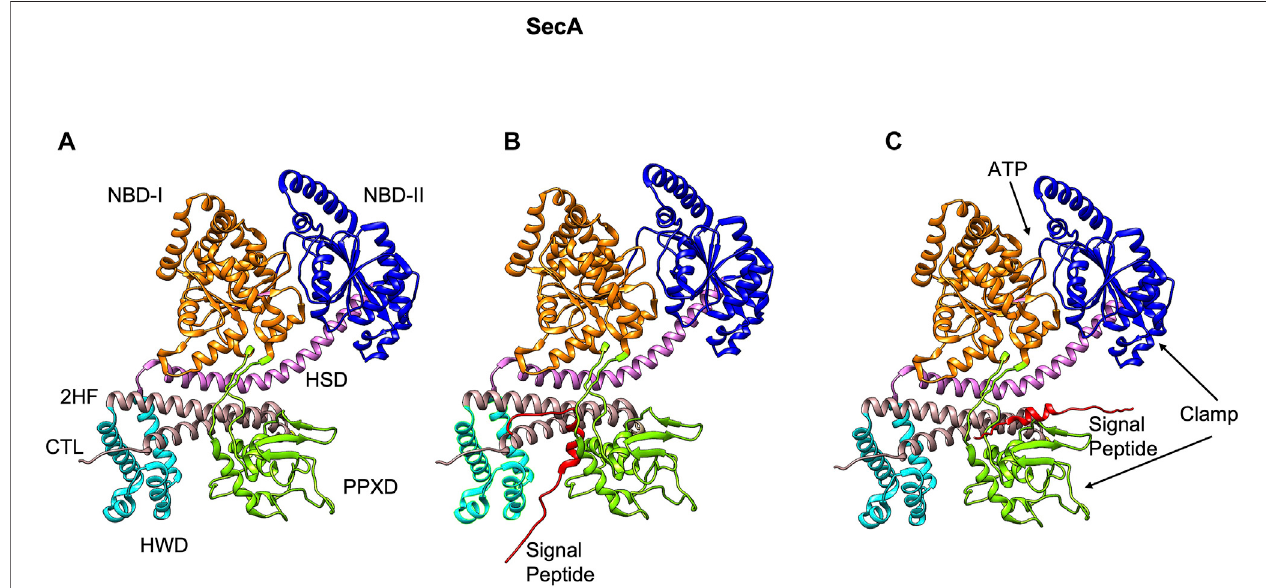
FIGURE 5 | The NMR structure of SecA from E. coli [adapted from Gelis et al. (2007) PDB: 2VDA]. (A) The various domains of SecA are highlighted (without the signal peptide). Thenucleotidebinding domains I(orange)and II(blue),thecentral helixsubdomain ofhelical scaffold domain (HSD inpurple),thepreprotein crosslinking domain (PPXDgreen),thehelicalwingdomain (HWDcyan),and theobservedcarboxyl-terminallinker domain (CTL).Also highlightedisthe2-helix fi nger(2HF tan) within the HSD domain. (B) The signal peptide (red) binds roughly perpendicular to 2HF based on NMR studies (Gelis et al., 2007). (C) The signal peptide is modeled parallel to the 2HF of the E. coli SecA NMR structure based on FRET, mutagenesis and genetic studies (Grady et al., 2012).